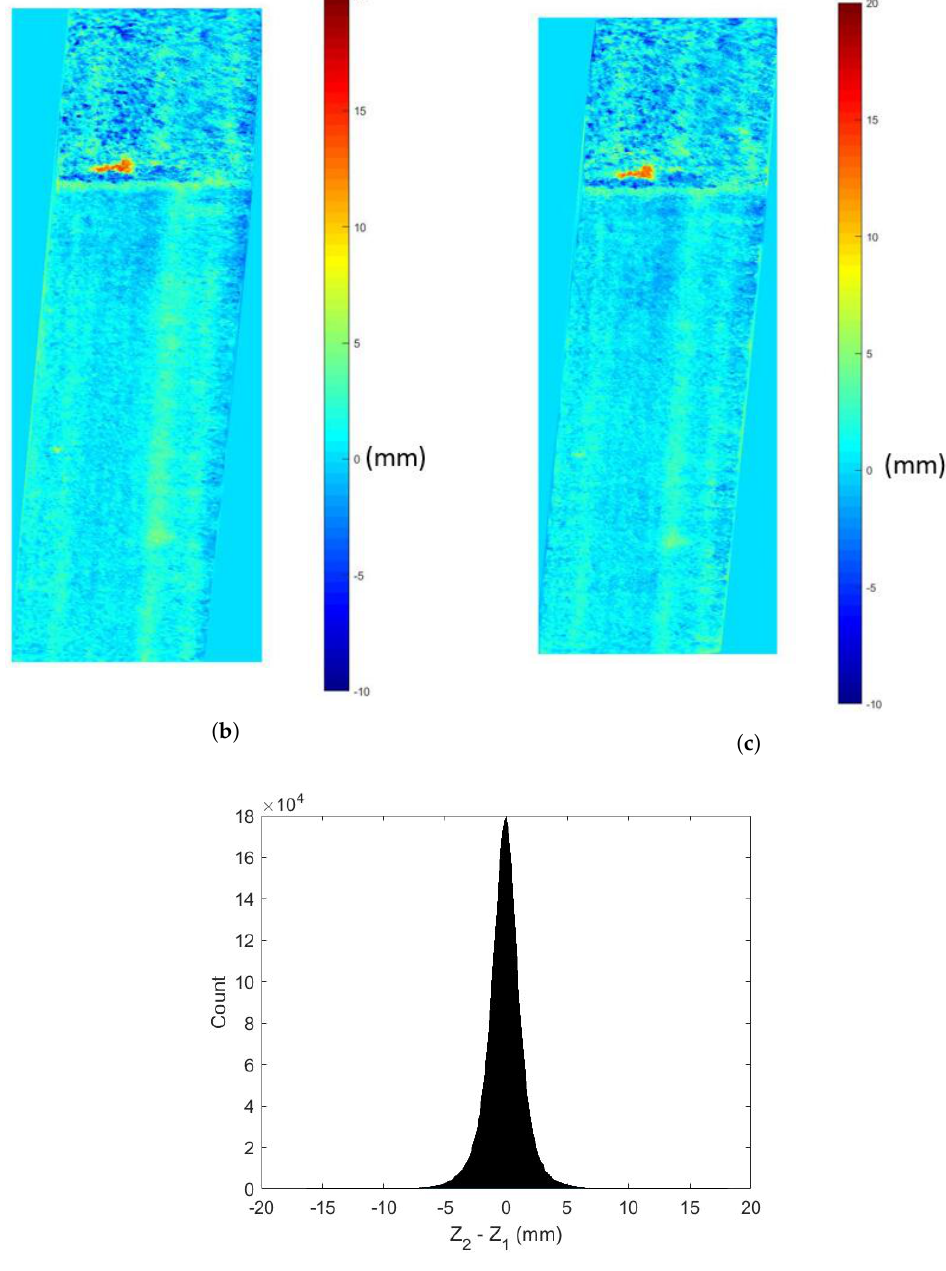
Figure 19. Repeatability test for the proposed technique. ( a ) Stitched images of a road section which has a geometrical defect. ( b ) The first measurement of one road section. { G } Z r − h values of road surface point cloud data are represented by a colormap. ( c ) The second measurement of one road section. { G } Z r − h values of road surface point cloud data are represented by a colormap. ( d ) Repeatability quantitative results. Z 1 are the { G } Z r values from the first measurement while Z 2 are the ones from the second